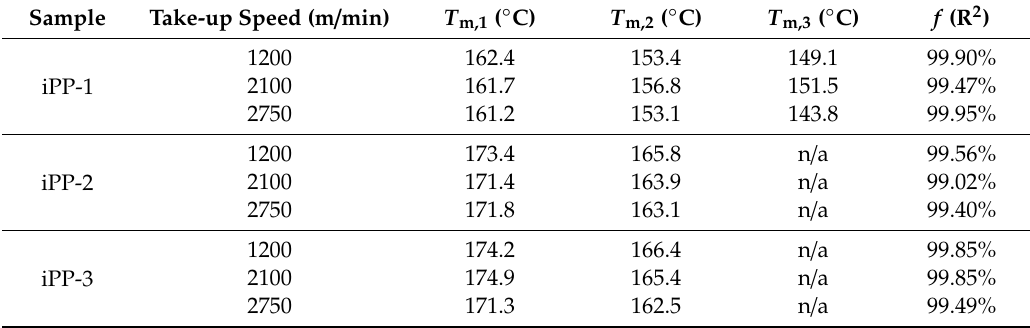
Table 9. Sub-peaks derived from DSC curves for drawn iPP fibers.